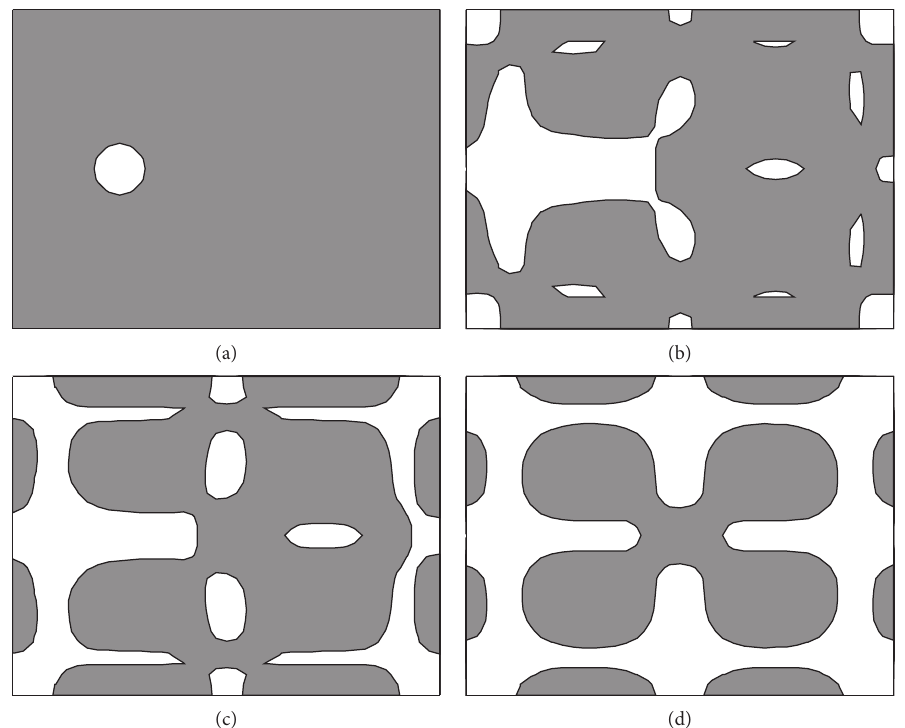
Figure 9: Evolution history of the optimized design of the damping layer for the 5th modal with one hole as the initial design. (a) Step 1. (b) Step 14. (c) Step 24. (d) Step 76.